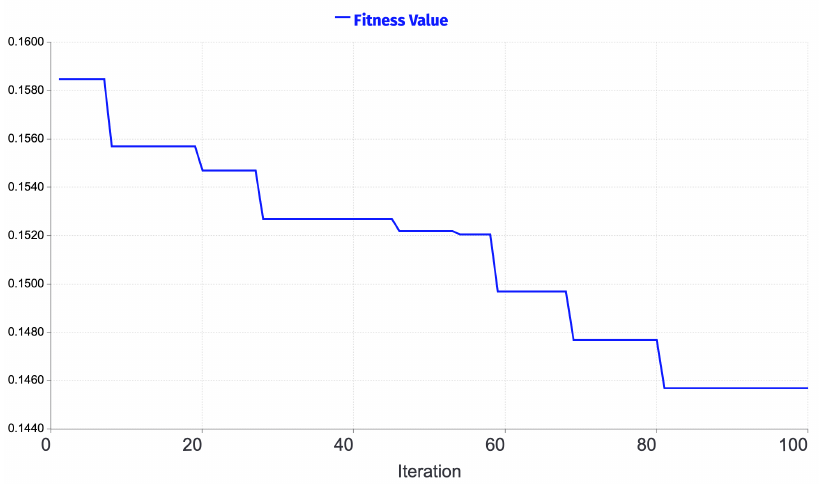
Figure A16. The training convergence curve when using the ANN with the CSO and the MSE fitness function for the dataset of Polish companies.